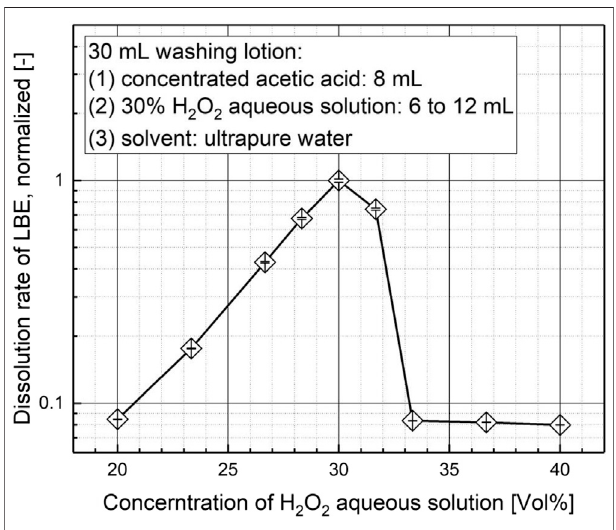
FIGURE 1 | Cleaning effect of washing lotions with different hydrogen peroxide